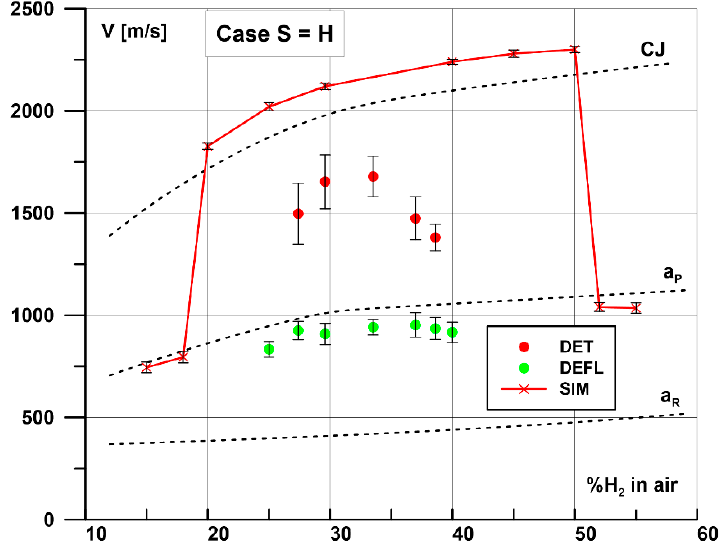
Figure 8. Propagation velocity as a function of mixture composition for S = H. Simulation results (line) and experimental results (dots) [31].